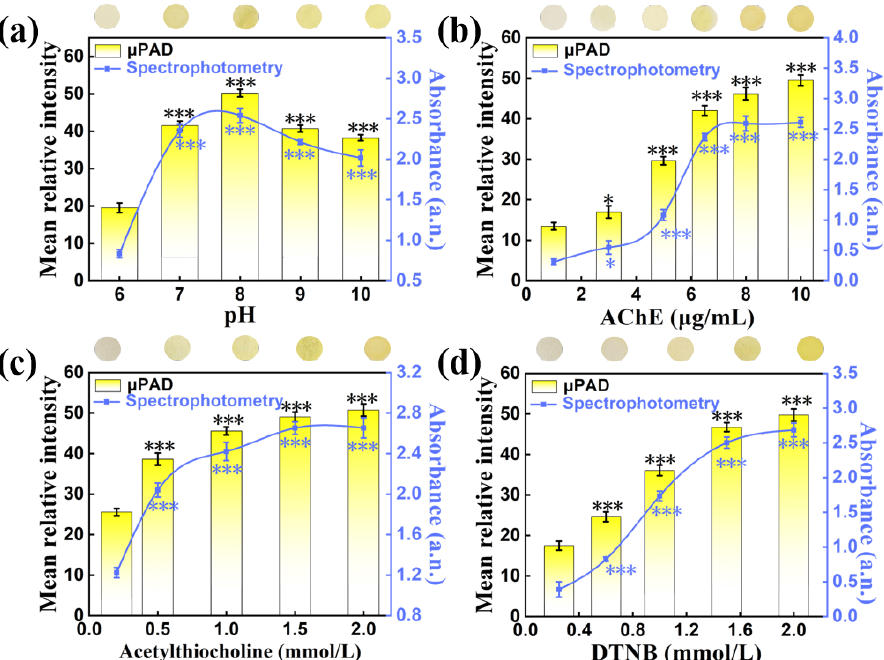
Figure 6. The effects of experimental conditions on pSBMA- µ PAD and spectrophotometry: ( a ) pH of system buffer, ( b ) the concentration of ATChI, ( c ) the concentration of AChE and ( d ) the concentration of DTNB. “*” stands for significance test.